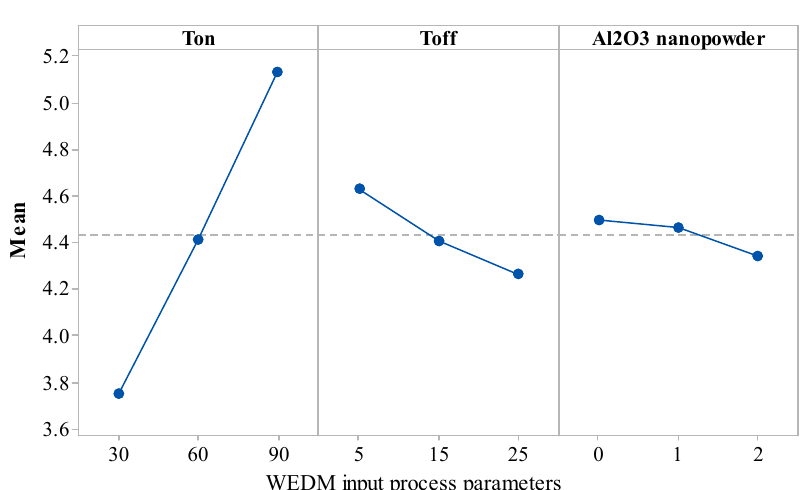
Figure 4. Influence of WEDM variables on SR.